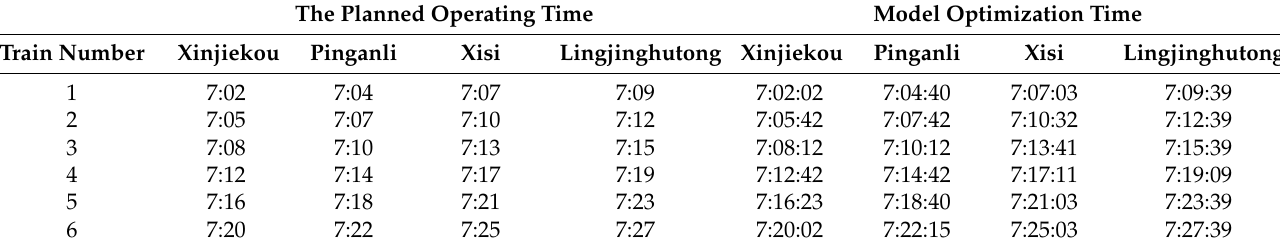
Table 9. Comparison of operating times.